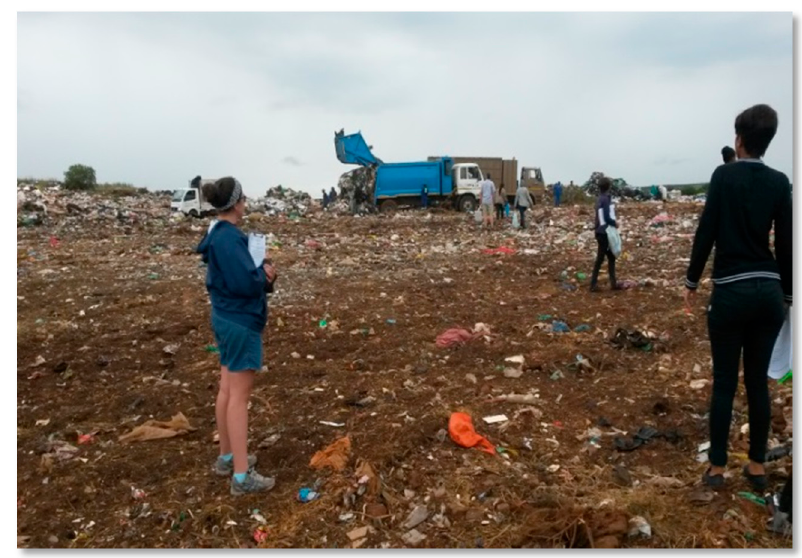
Figure 4. Separating man and machine on the landfill. Source: Authors.